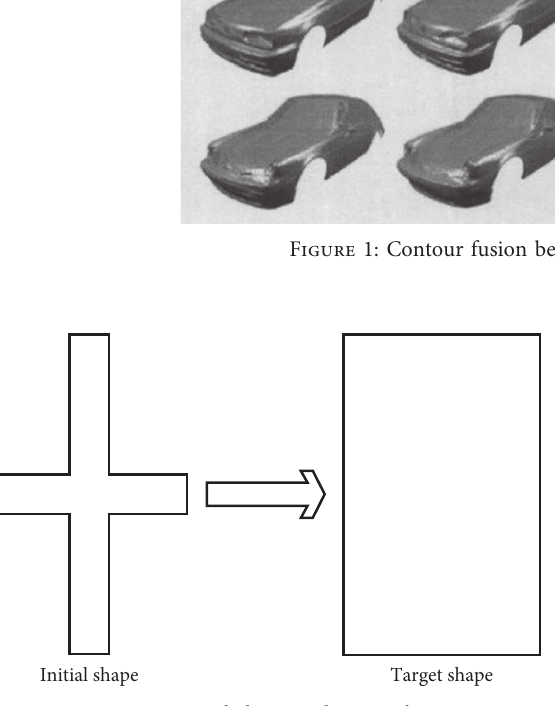
Figure 2: Initial shape and target shape.